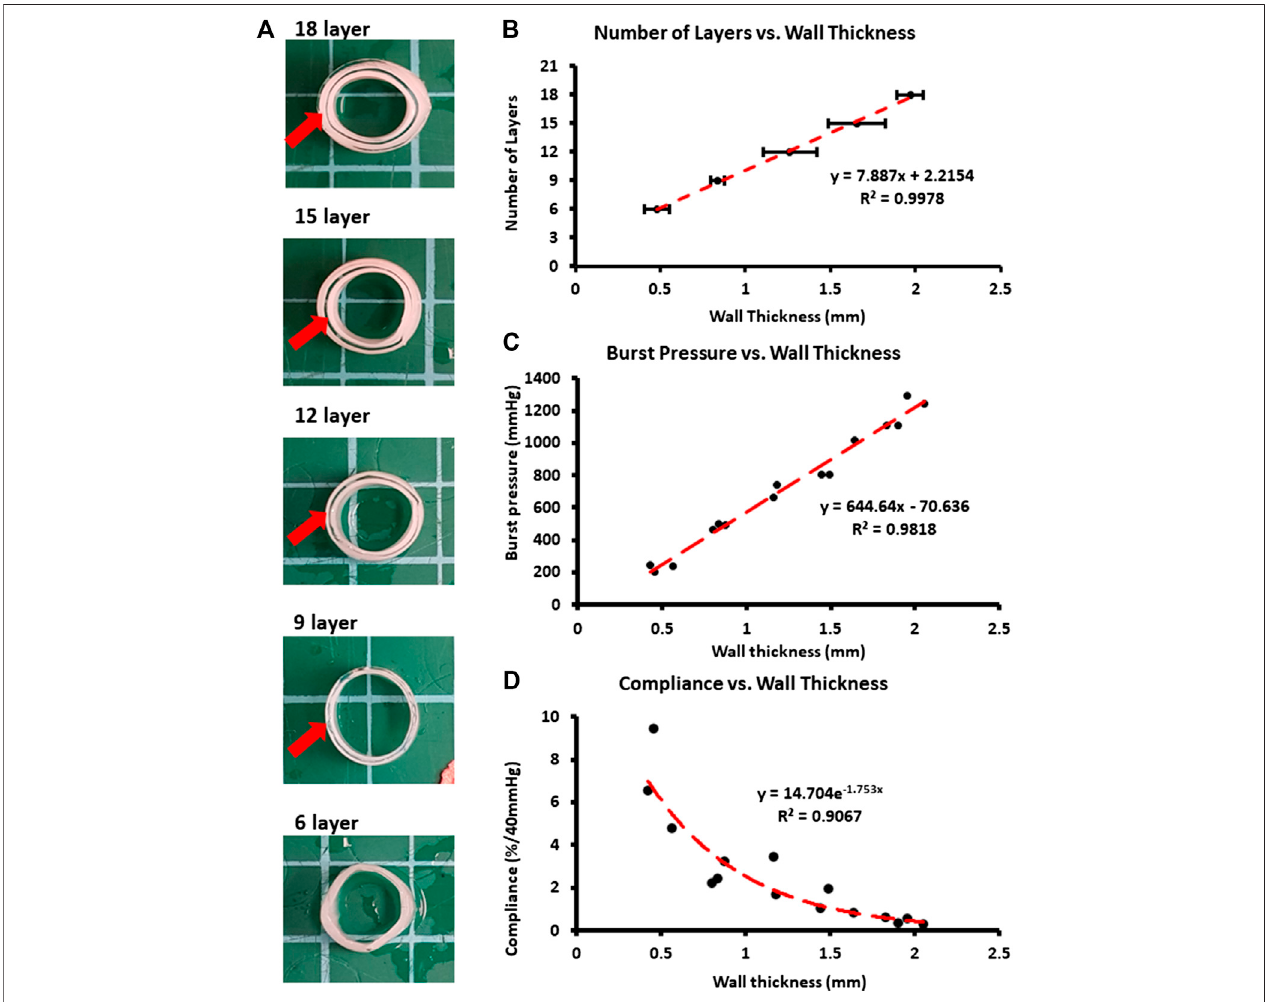
FIGURE2| Physicalandmechanicalcharacterizationofgraftswithdifferentialnumberoflayers. (A) Cross-sectionalimages.Redarrowsusedtoidentifydifference level of transparency between layers. (B) Wall thickness of the samples for differential number of layers. (C) Burst pressure plotted against the wall thickness. (D) Compliance plotted against the wall thickness. * p ＜ 0.05 between indicated groups. n (cid:2) 9 for all groups. Error bar represents standard deviation.